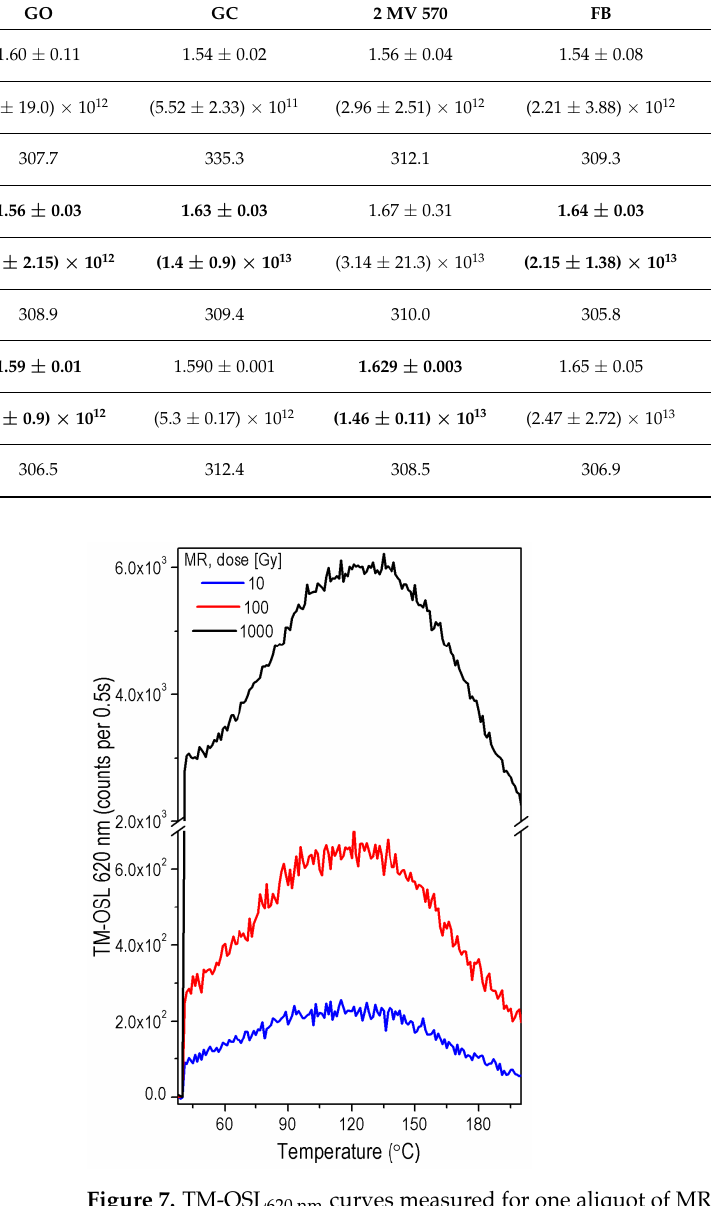
Figure 7. TM-OSL 620 nm curves measured for one aliquot of MR sample after irradiation with a dose: 10 Gy (blue), 100 Gy (red) and 1000 Gy (black) and preheat up to 280 °C. It is worth noting that the positions of the first-order TL peaks obtained for all the results presented in Table 2 (Figure 8) do not differ significantly, except in two cases: sample GC measured with dose 10 Gy (red line) and MR with 1000 Gy (magenta dot line). We attribute this behavior to the dependence of OTDC results on the initial filling of traps active in the processes taking place in the OTDC measurement, as indicated earlier in the simulation study [37] (see Section